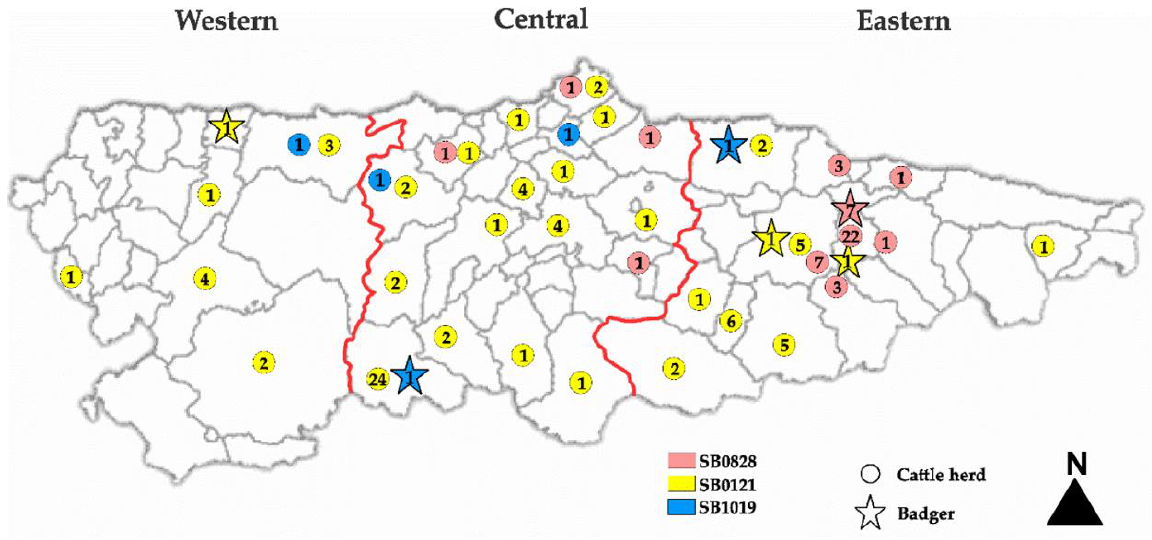
Figure 3. Shared Mycobacterium bovis spoligotypes (SB) identified in badgers and cattle herds in the three regions of Asturias (Atlantic Spain) from 2008 to 2020. The numbers within the color circles or stars indicate the number of badgers or cattle herds, respectively, positive to that SB during the 13-year follow-up. Red lines within the map establish the three regions of Asturias. The rates of MTC positivity were 13.27% (13/98) among trapped badgers and